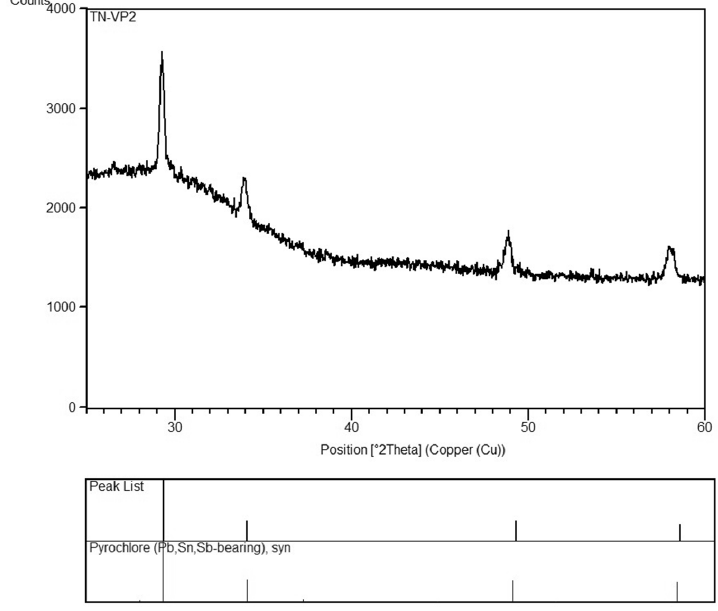
Figure 9. XRPD pattern of tessera TN VP2 opacified by generic synthetic pyrochlores, containing Pb, Sb and Sn. Similar pattern shown by PN GSO1, PN VP1, PN VG1, TN VS2, TN GSO1, TN GSO2, and TN VP1.